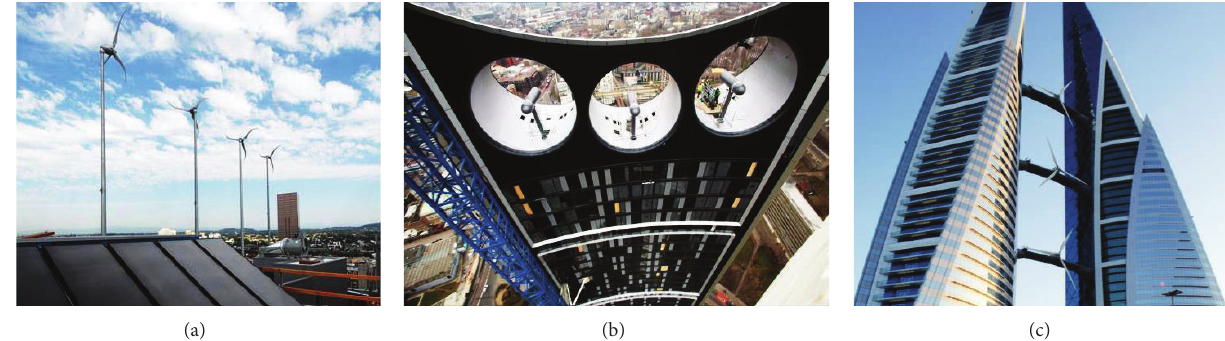
Figure 1: (a) Wind turbines on the roof of twelve west buildings, (b) the Strata tower with three building-integrated wind turbines, (c) Bahrain tower.